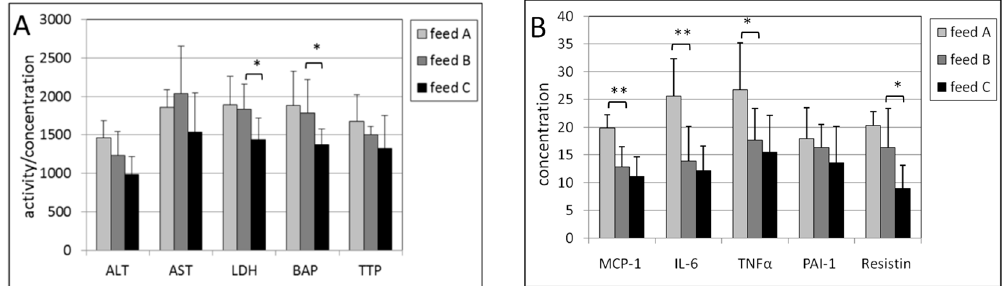
Figure 3. ( A ) Activities of ALT, AST and LDH, and concentrations of BAP and TTP in the post-mitochondrial supernatant of liver tissue of male mice. The levels of LDH, BAP and TTL were multiplied by a factor of 0.2, 10 and 20, respectively to fit in the figure; ( B ) Concentrations of MCP-1, IL-6, TNF- α , PAI-1 and resistin in the post-mitochondrial supernatant of liver tissue of male mice. The levels of IL-6, TNF α and resistin were multiplied by a factor of 4 to fit in the figure. The levels of feed B were tested statistically relative to those of feed A, and the levels of feed C relative to those of feed B. * p < 0.05, ** p < 0.01.